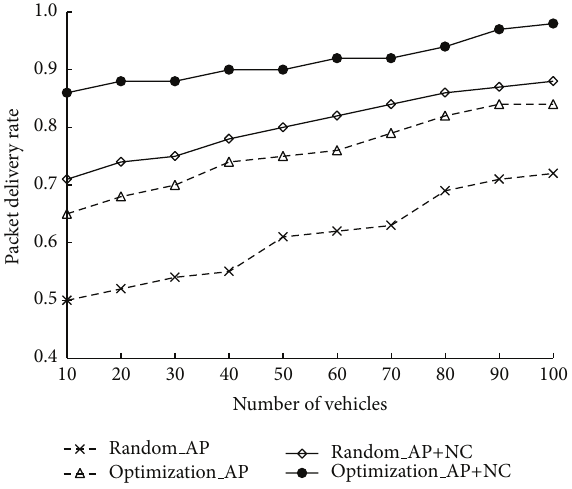
Figure 1: Comparison chart of packet delivery rate.